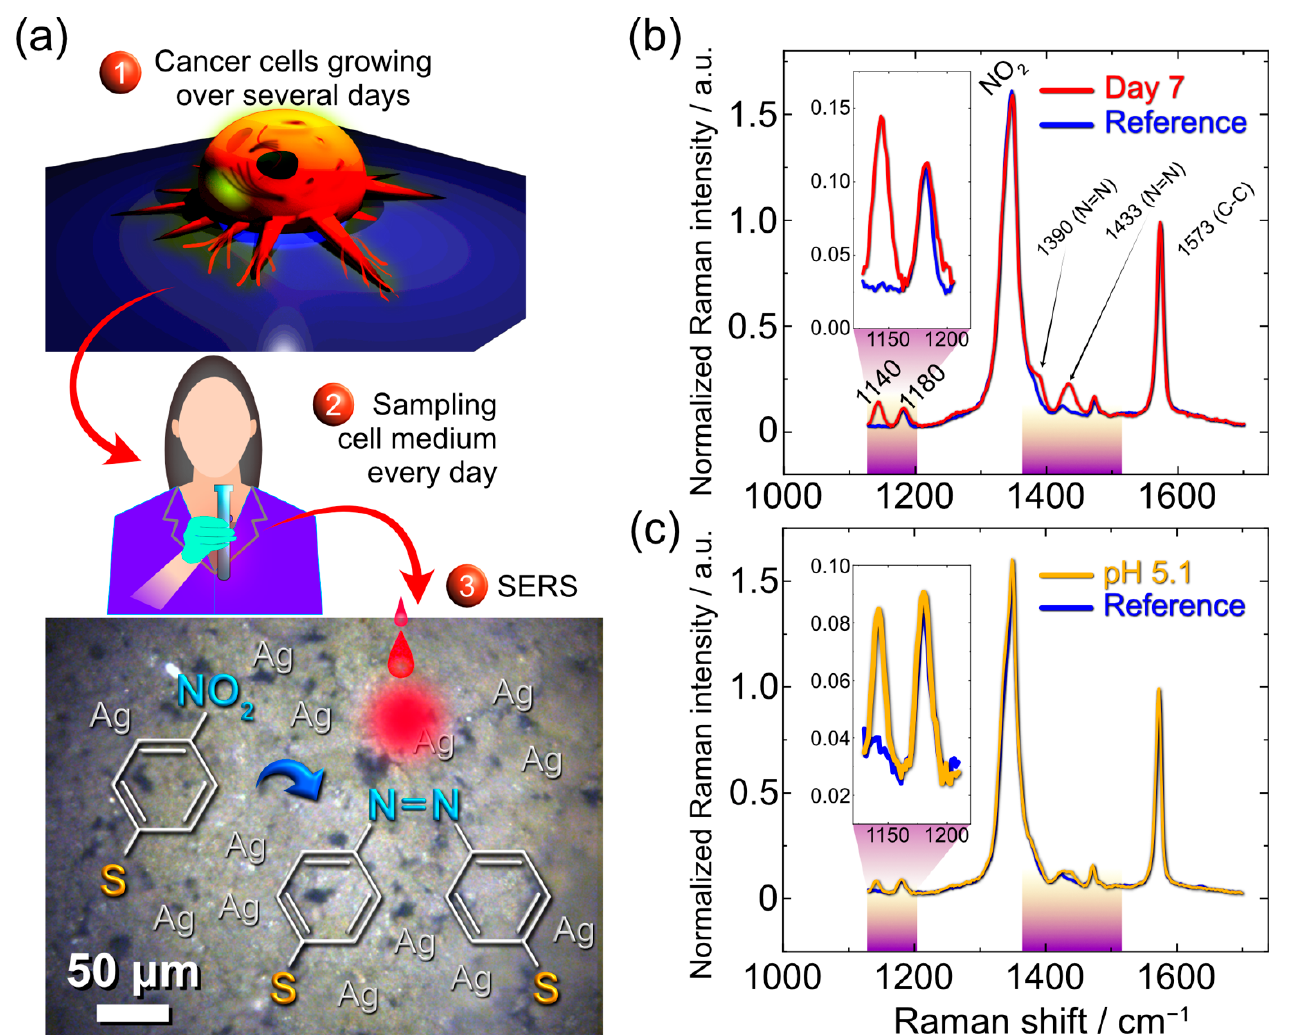
Figure 3. ( a ) Schematics of the experiments with prostate cancer PC3 cell line RPMI media. Culture media were extracted every day. ( b ) Raman spectrum of cell media extracted on the seventh day on AgLIMPc/4-NBT substrate with the reference spectrum of water on the same substrate. The regions of interest with the main changes are marked in the spectra. ( c ) Spectra comparison of the AgLIMPc/4-NBT covered with a pH buffer (pH = 5.1) and